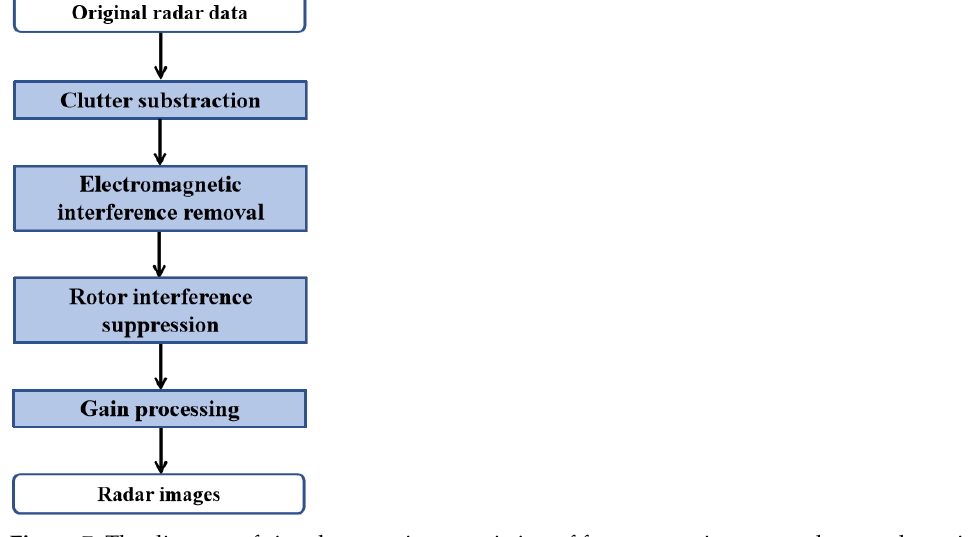
Figure 7. The diagram of signal processing, consisting of four processing steps: clutter subtraction, electromagnetic interference removal, rotor interference suppression, and gain